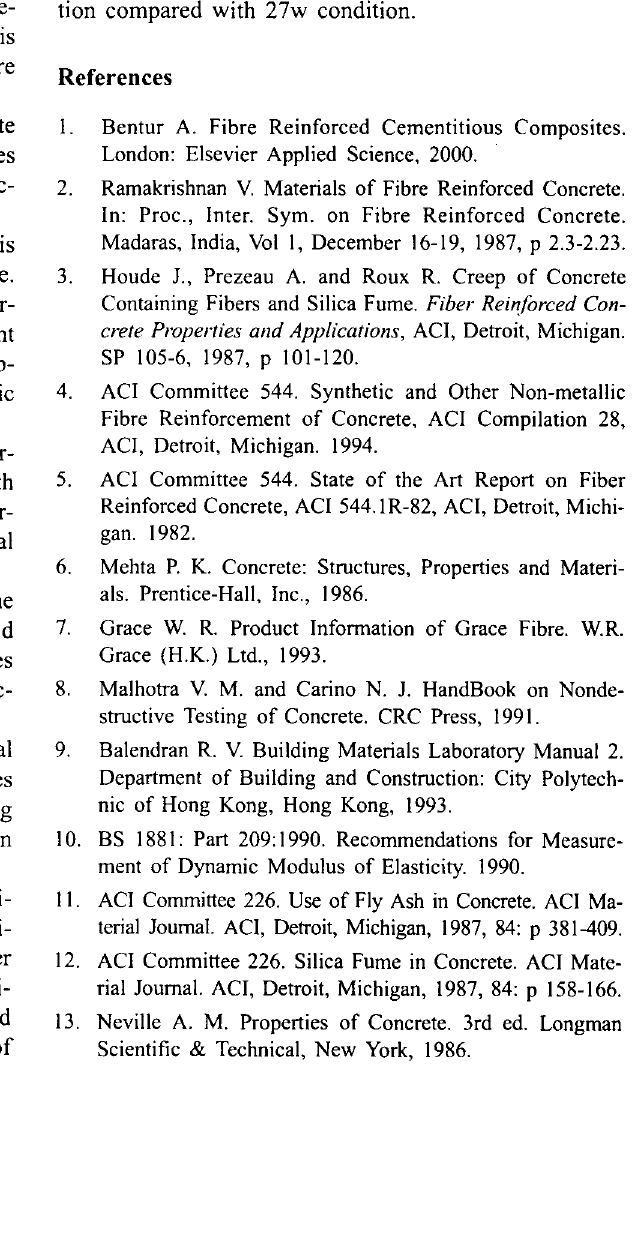
Table 9. The relative percentage of resonant frequency of each mix under different curing conditions relating to those mixes under 27w condition at 28 days Relative percentage compared with the strength under 27w condition at 28 days Mix Curing conditions* 3 days 7 days 28 days 91 days c 90,6% 93,9% 97,4% 98,2% CP a 88,7% 92,8% 95,8% 96,3% CPF 87,7% 91,5% 94,7% 95,4% CPS 90,0% 93,5% 96,6% 97,2% c 93.0% 98,1% 100% 101,1% CP 27w 92,4% 97,0% 100% 101.1% CPF 90,8% 95,1% 100% 100,8% CPS 92,7% 97,6% 100% 101,3% c 96,0% 100.3% 102,0% 103,0% CP 38w 94,9% 99,5% 101,4% 102,0% CPF 92,6% 97,8% 100,5% 101,5% CPS 95,0% 99,4% 101,5% 104,4%